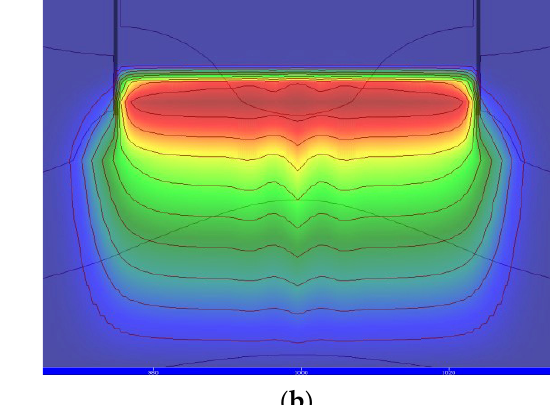
Figure 22. Diagram of bacterial migration driven by the seepage field in the inner circle after the infusion of the bacteria solution was stopped: ( a ) Horizontal; ( b ) Vertical.